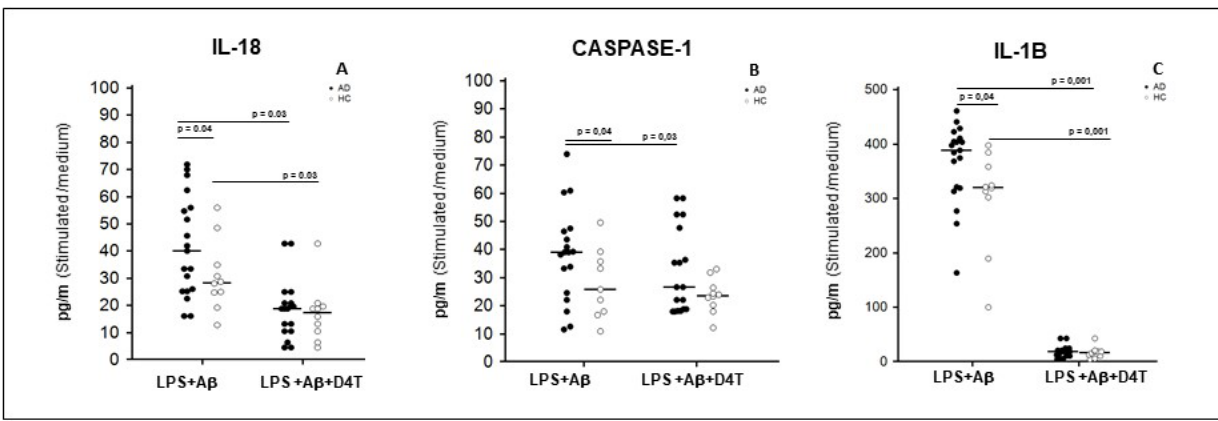
Figure 2. Cytokines and caspase-1 production. IL-18 ( A ), Caspase-1 ( B ), and IL-1 β ( C ), production was assessed by multiplex ELISA in supernatants primed with lipopolysaccharide (LPS) (1 µ g/mL) and stimulated with A β 42 (10 µ g/mL) in the presence/absence of D4T (Stavudine) (50 µ M) PBMC of AD (black dots) patients and Healthy Controls (HC) (white dots). Summary results are shown in the dots-plot-graphs. Summary results are shown in the dots-plot graphs are expressed as the cytokines and caspase-1 production (pg/mL) between results obtained in stimulated cells/medium (unstimulated cells). Horizontal bars indicate medians. Statistical significance is shown.